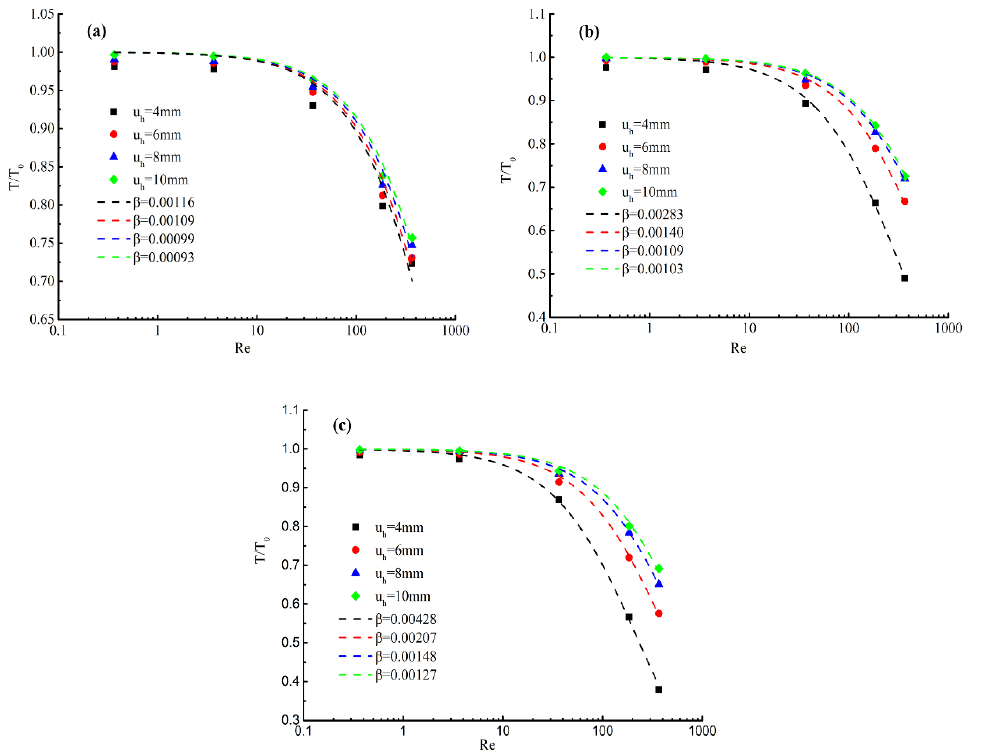
Figure 10. Relationship between normalized transmissivity and Reynolds number, ( a ) σ n 0 = 0.4 MPa; ( b ) σ n 0 = 0.8 MPa; ( c ) σ n 0 = 1.6 MPa.